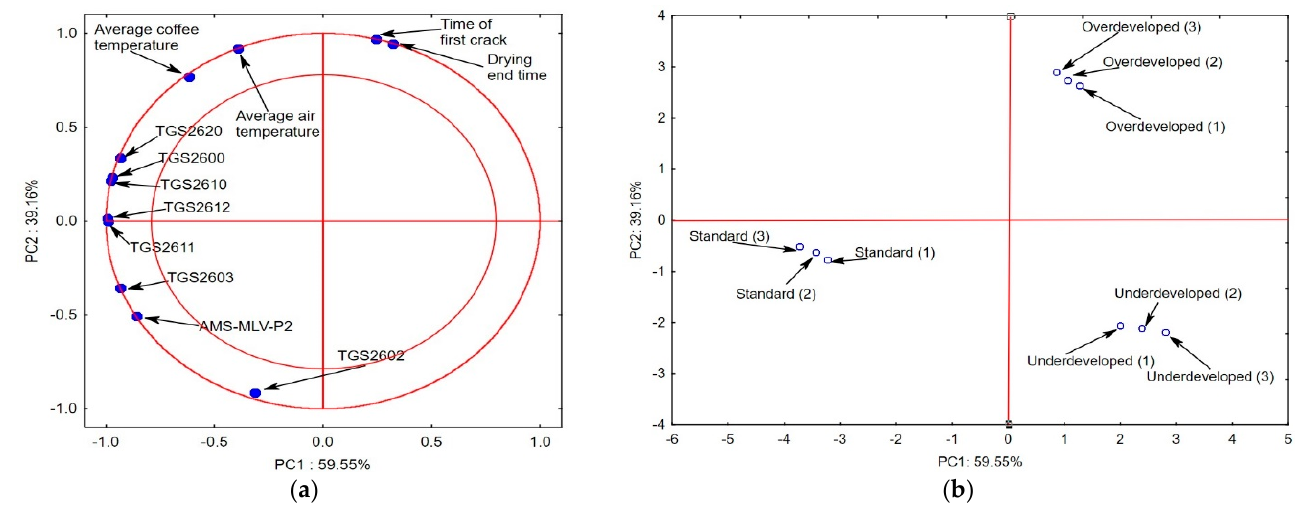
Figure 3. Projection of variables: responses of electronic nose sensors to different kinds of coffee roasting style, temperature of air, temperature of beans, and time to the first crack on the PC1 and PC2 scores plot—( a ); projection of cases characterizing the type of roasting on the PC1 and PC2 loadings plot—( b ).